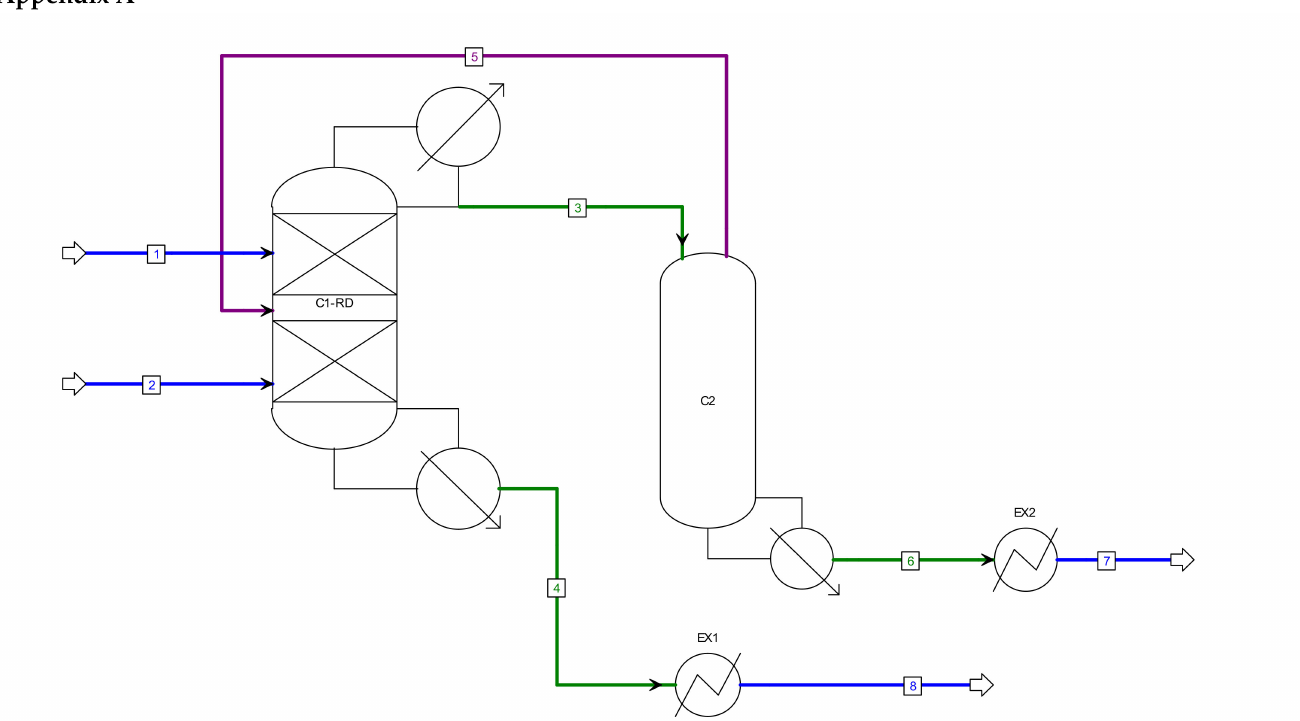
Figure A1. Ethyl acetate production via reactive distillation column with a stripper adapted from our previous work [5]. Stream condition: blue—subcooled liquid; green—liquid at boiling temperature; purple—saturated/overheated vapor. C1-RD—reactive distillation column; C2—stripper column; EX1, EX2—heat